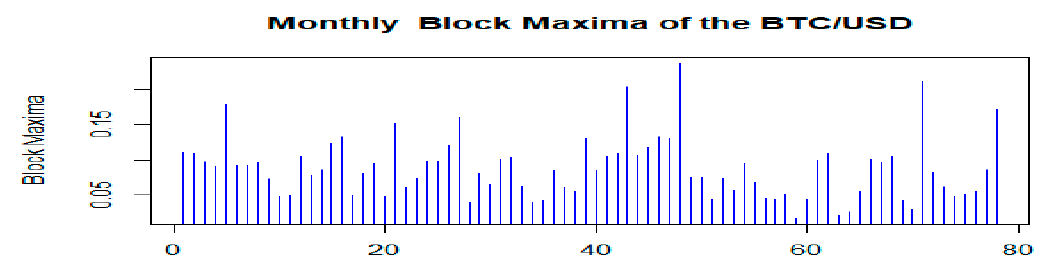
Figure 3. Block maxima for upper tail (gains) for BTC/USD.